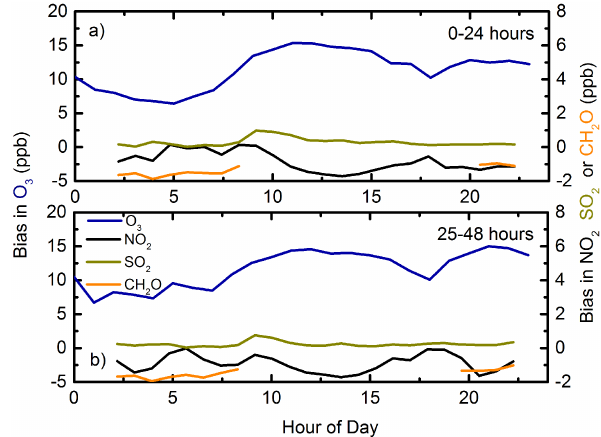
Figure 14. CMAQ model bias at Kenosha for O 3 (in blue, left axis), NO 2 (black), SO 2 (brown) or formaldehyde (orange) (right axis) for (a) 1–24h forecast and (b) 25–48h